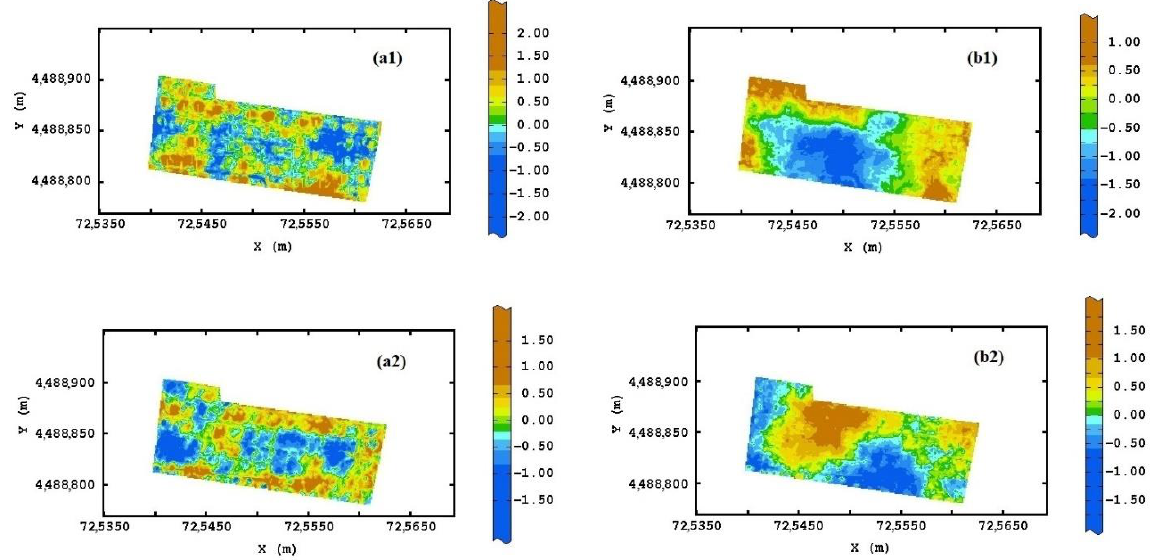
Figure 13. Maps of the first two regionalized factors at short range ( a1 , a2 ) and of the first two regionalized factors at long range ( b1 , b2 ). Colour scale uses isofrequency classes.